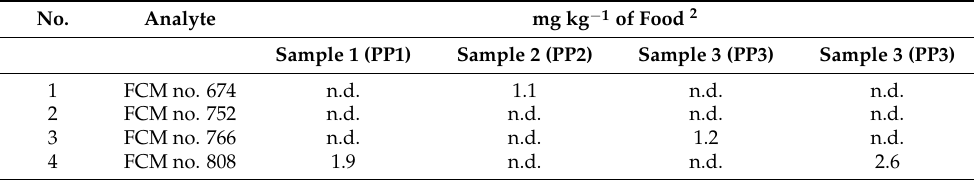
Table 5. Method application to real FCM samples, after performance of migration testing 1